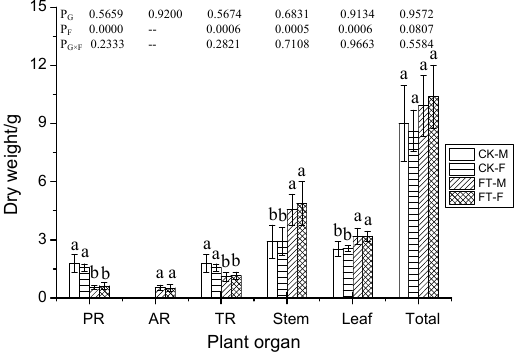
Figure 2. The dry weight of primary root, adventitious root, total root, stem, leaf, and sapling (total) of male vs. female Salix viminalis plants at the end of flooding treatment. PR, primary root; AR, adventitious root; TR, total root.